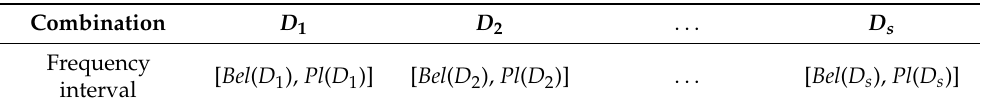
Table 2. Frequency interval of D i .